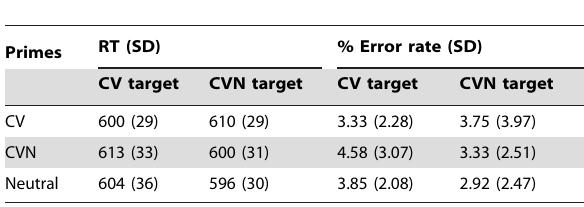
Table 4. Mean naming latencies (in ms) and mean percentage of errors (%) with standard deviation in parentheses in Experiment